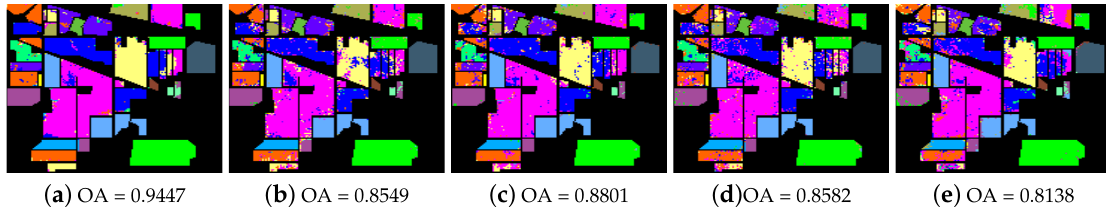
Figure 11. NN classification results on noisy Indian Pines image (noise variance σ = 250) obtained by: